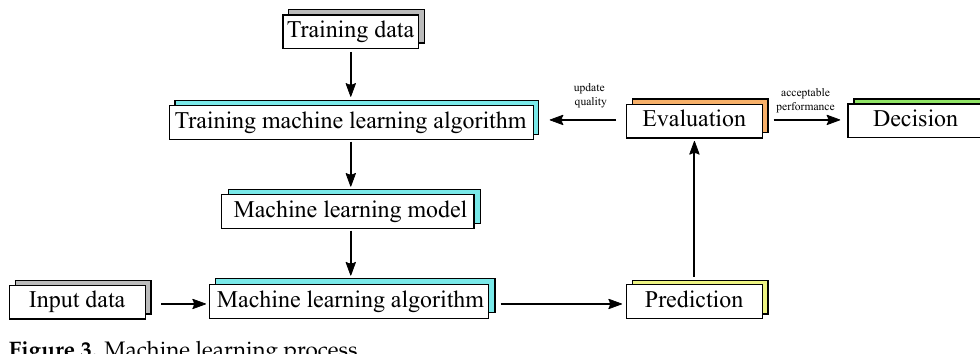
Figure 3. Machine learning process.